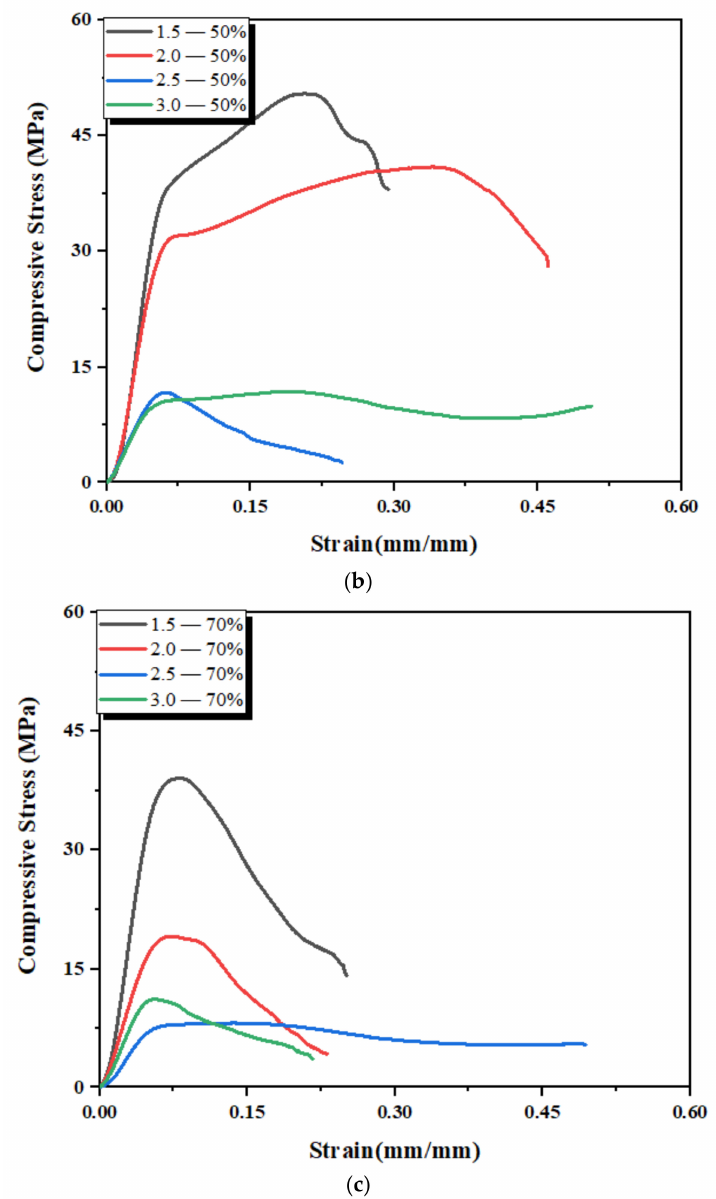
Figure 11. Stress–strain curves of PolyJet 3D-printed scaffold structures with a hexagonal closed packed pore shape at ( a ) 30%, ( b ) 50%, and ( c ) 70% with 1.5 mm, 2.0 mm, 2.5 mm, and 3.0 mm pore